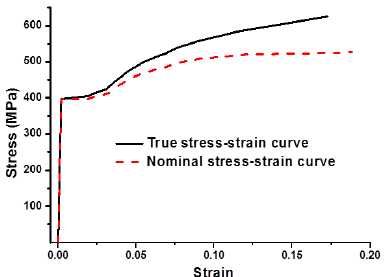
Figure 8. Stress ‐ strain curves of uncorroded reinforcing bar. Figure 8. Stress-strain curves of uncorroded reinforcing